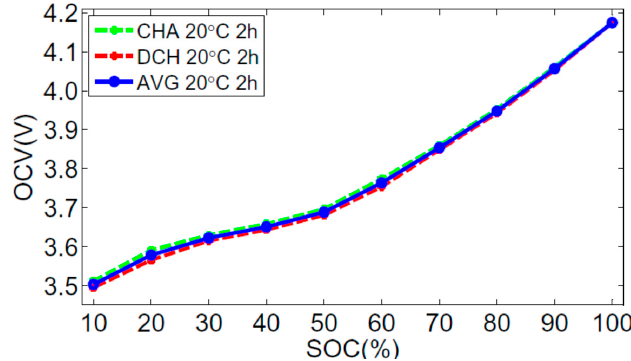
Figure 4. Battery SOC-OCV curves: CHA, charging; DCH, discharging; AVG, averaging.